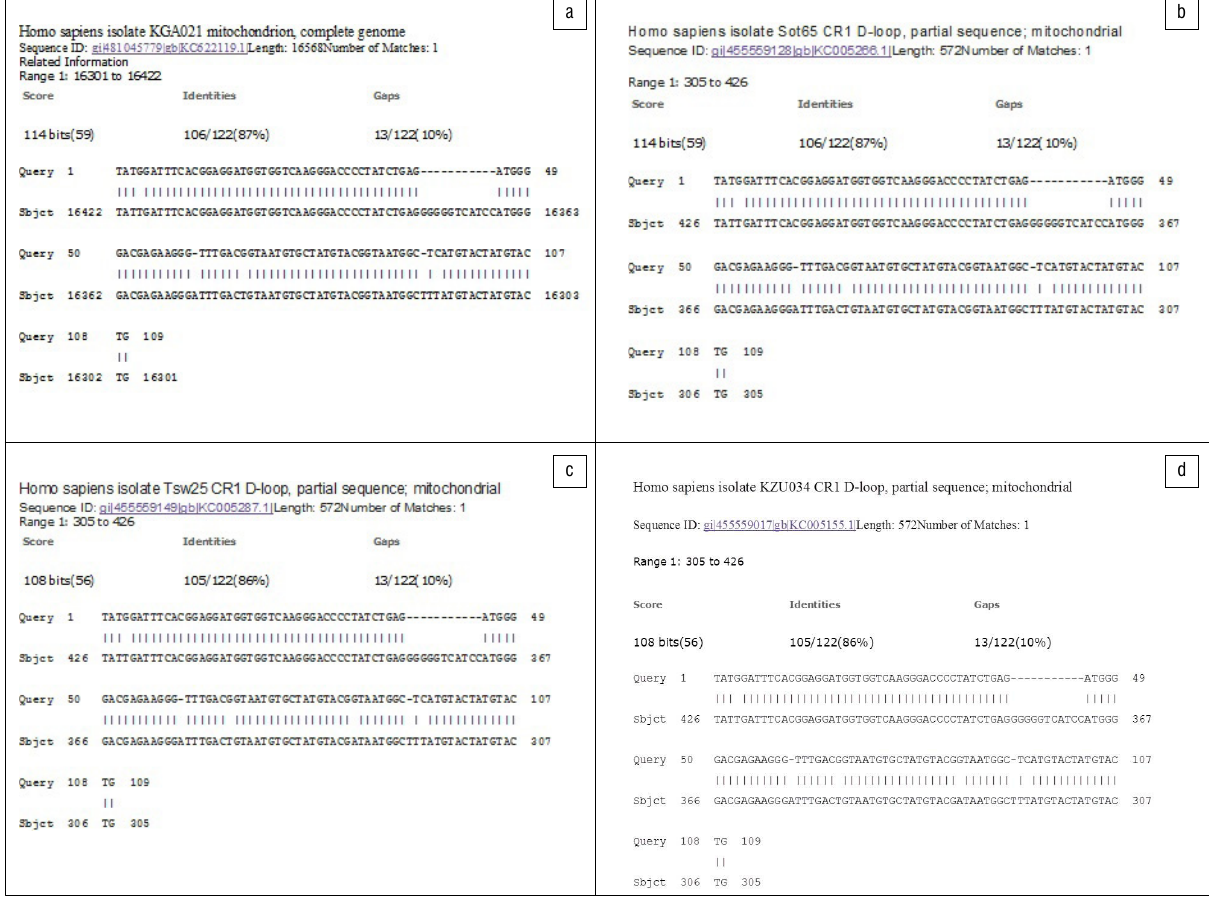
Figure 7: Alignment of the Tuli HVRI sequence against reference sequences representing a (a) Kgalagadi, (b) Sotho, (c) Tswana and (d) Zulu individual,